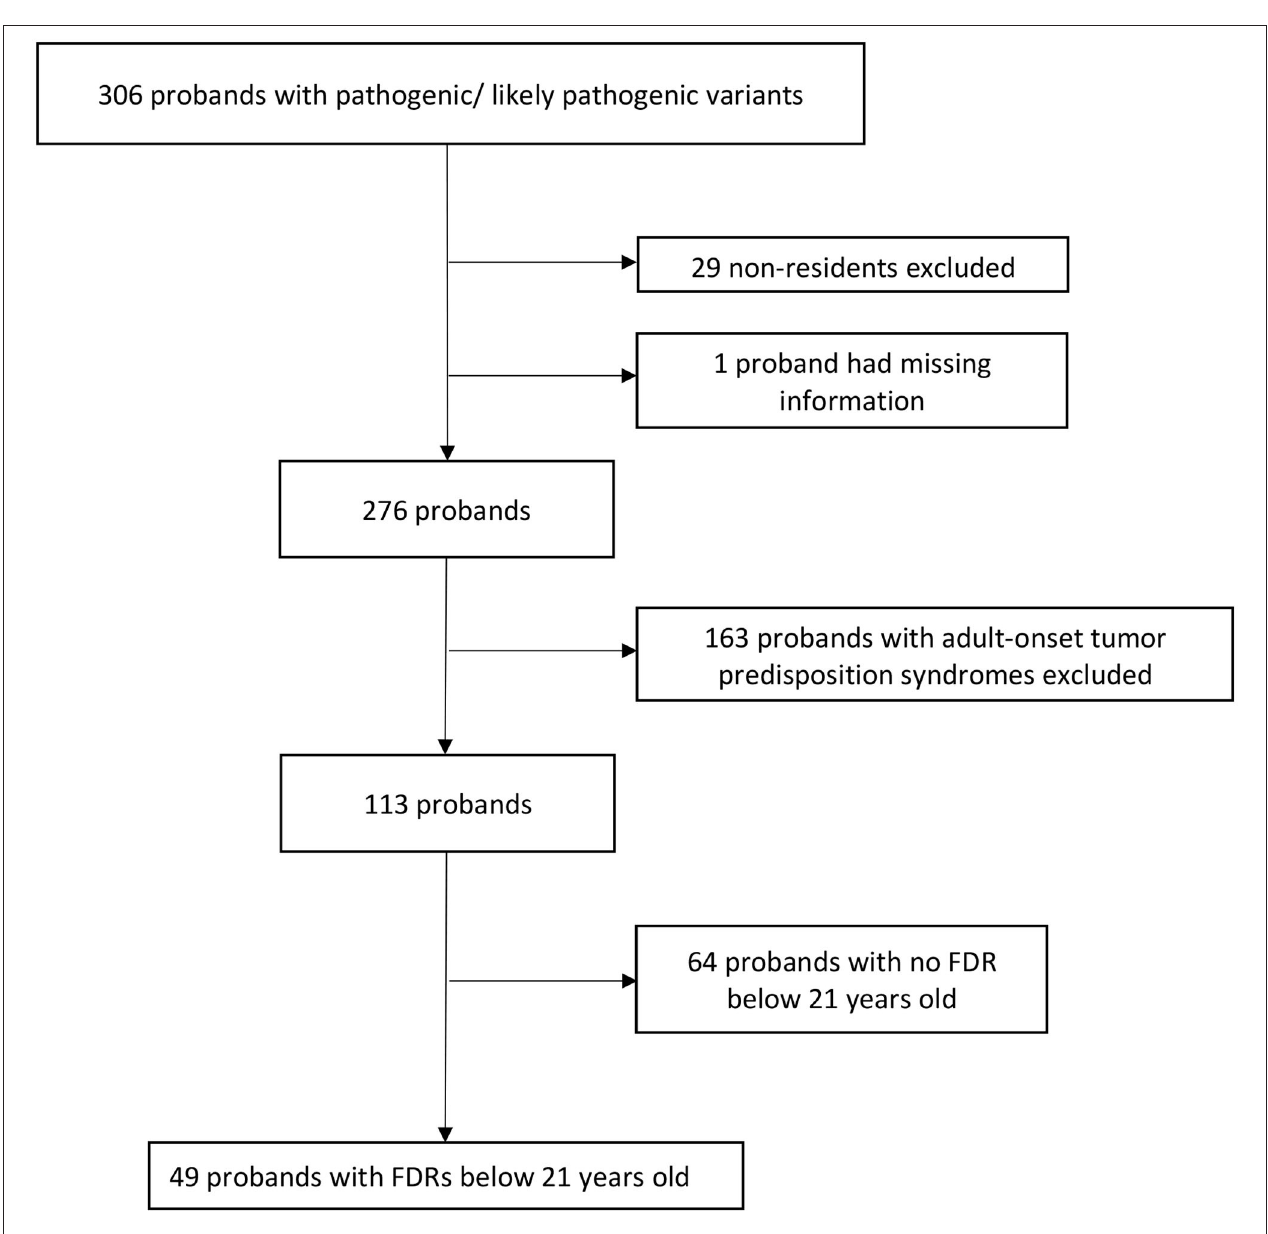
FIGURE 1 | Exclusion criteria of study. FDRs, first-degree